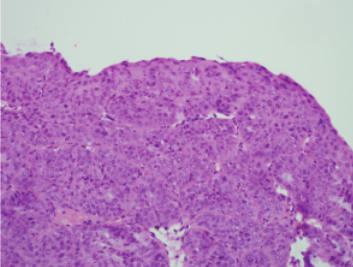
Figure 1: Prostate adenocarcinoma from biopsy (hematoxylin and eosin, 200x).